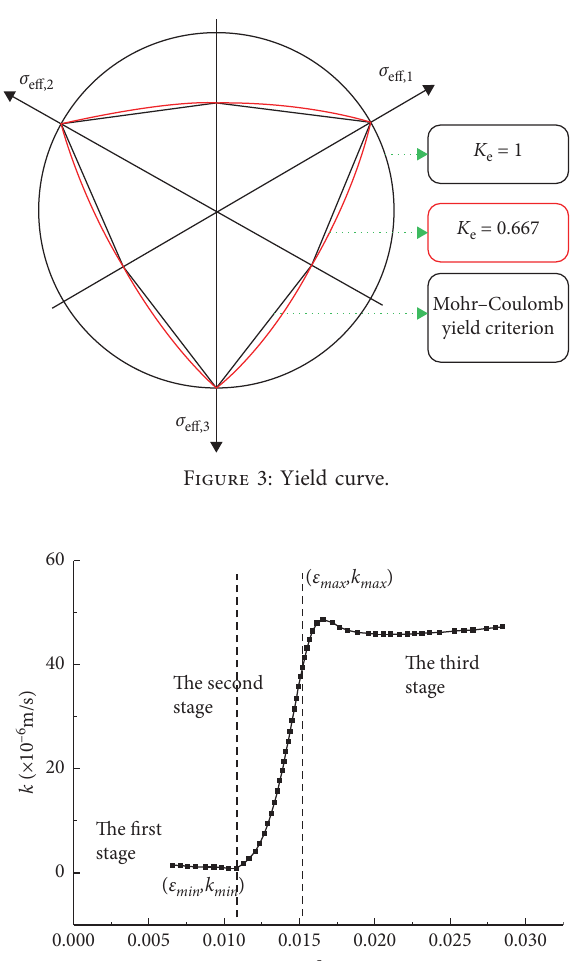
Figure 4: Evolution law of coal matrix permeability coefficient during the full stress-strain